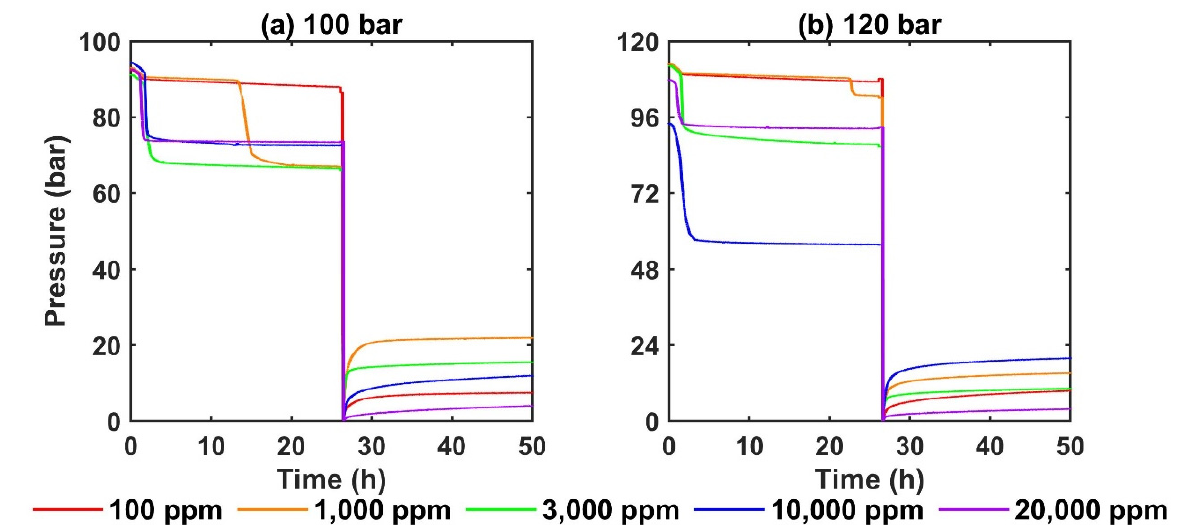
Figure 11. Pressure variation during cooling T < 0 ° C in the presence of histidine for different concentrations. First part of pressure variation on account of cooling below 0 ° C (temperature reduced from 1 ° C to − 2 ° C ) and second part of pressure variation due to self-preservation. For self-preservation, the pressure inside the cells was quickly reduced to atmospheric pressure thereafter valve was closed (at T = − 2 ° C ) ( a ) shows the pressure response curve for P 1 = 100 bar. ( b ) shows the pressure response curve for P 1 = 120 bar.